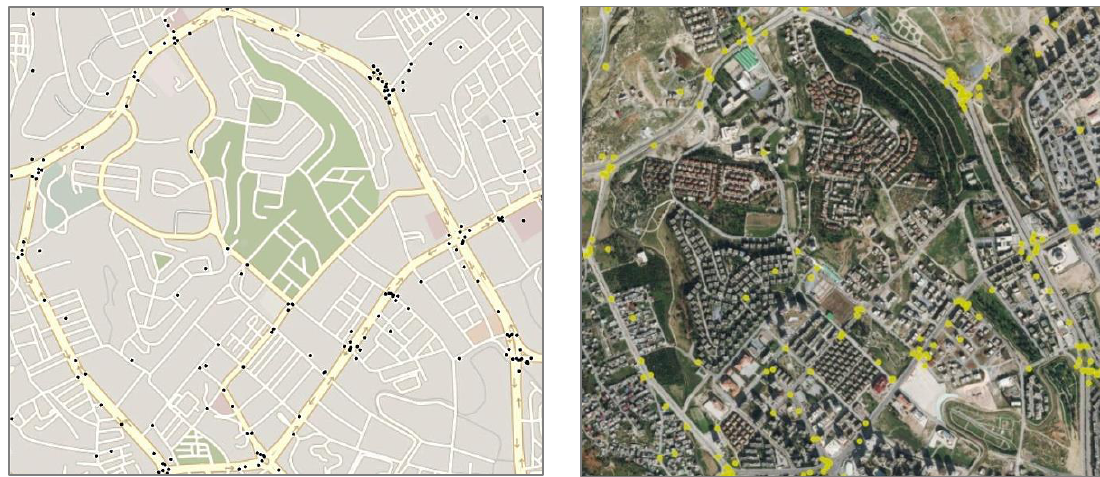
Figure 9 Street Network and Location of Accidents in Çağdaşkent